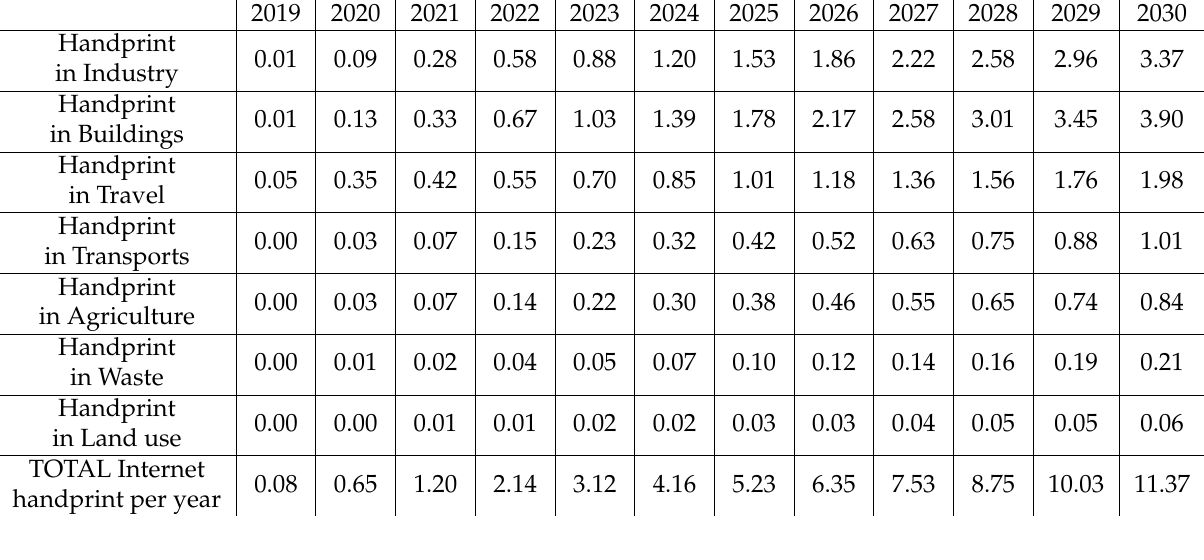
Table 17. Estimation of global GHG supply (Gigatonnes) with and without ICT handprint and Share of electric power GHG, 2019-2030.